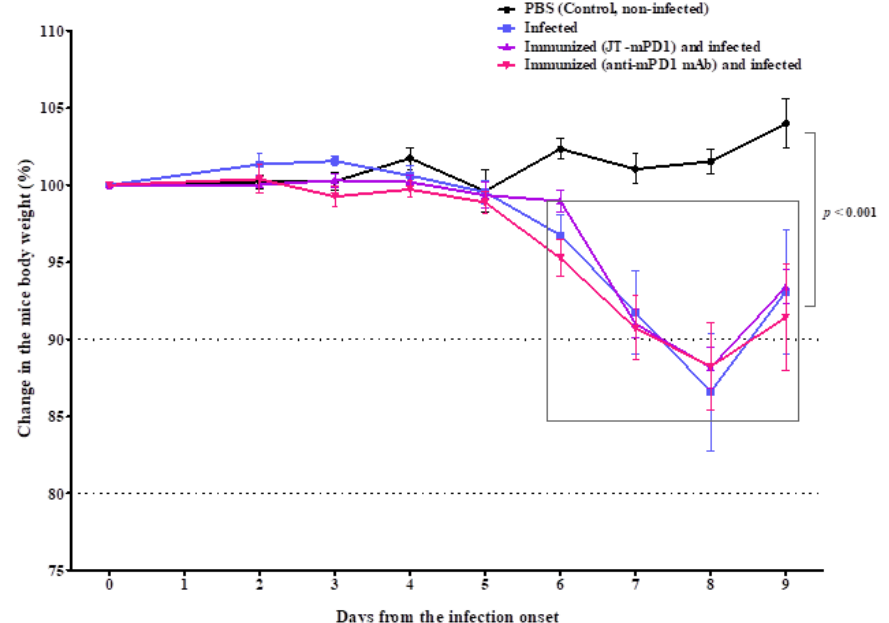
Figure 4. On the day of the infection (day 0) and each day after the infection, the body weight of the mice was measured. Each point indicates an average of 5 mice, shown with SE. Significant differences are indicated by the respective p -values.